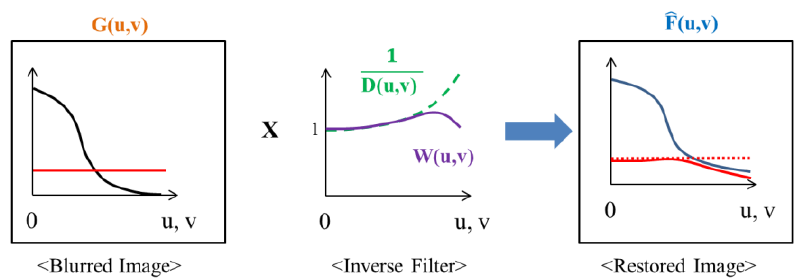
Figure 12. Effect of Wiener filter. Figure 12. E ff ect of Wiener filter.